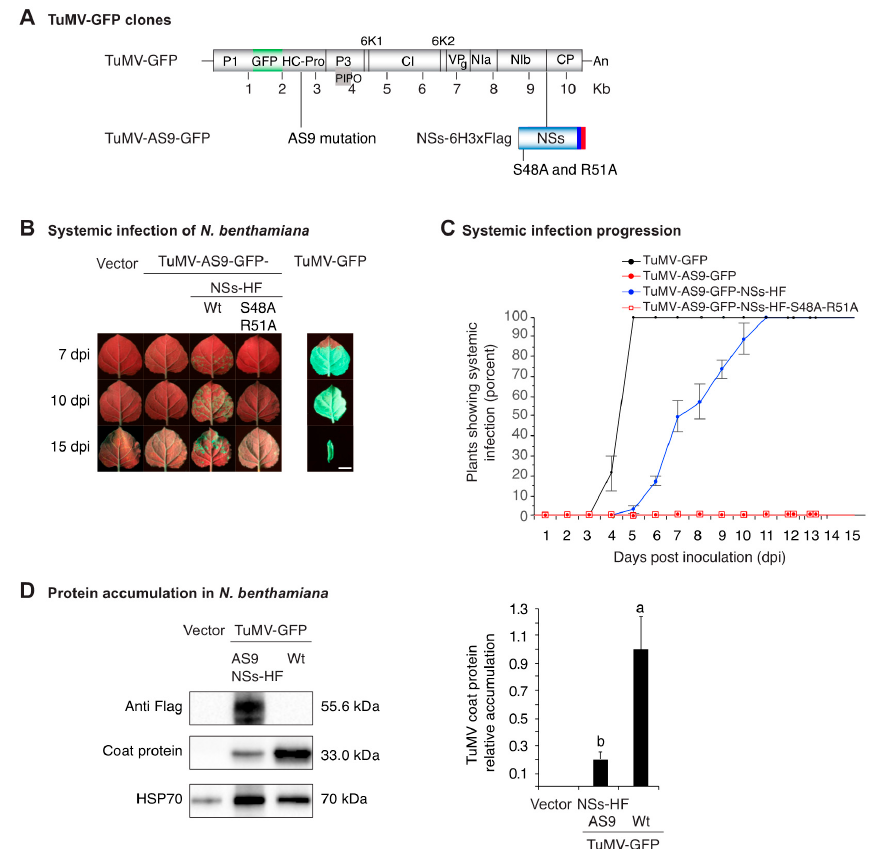
Figure 2. Pathogenicity in N. benthamiana and accumulation of suppressor-deficient TuMV-AS9-GFP derivatives expressing NSs-HF. ( A ) Representation of TuMV-GFP clones showing insertion of GFP between P1 and HC-Pro, the AS9 mutation on HC-Pro, and insertion of NSs-HF between NIb and the coat protein. An NIa cleavage site (CVYHQ/A) was added between NIb and NSs-HF and between NSs-HF and the coat protein to promote release of NSs-HF after polyprotein processing. Inactivating mutations on NSs RNA binding motif one are indicated. ( B ) Visualization under UV light of systemic infection in leaves at 7, 10 and 15 dpi. TuMV-GFP is shown for comparison. Scale bar: 2 cm. ( C ) Proportion (%) of plants showing systemic infection as determined by UV illumination. Points represent average ( ± standard error) of three repetitions, each consisting of 12 plants per treatment. ( D ) Virus accumulation in systemically infected leaves at 10 dpi. Representative western blots showing NSs-HF and coat protein accumulation in the same sample. HSP70 was used as a loading control. The blot was cut in three parts before antibody probing. The histogram shows average coat protein accumulation ± standard error (four biological replicates) relative to TuMV-GFP. Bars with the same letter are not significantly different (Tukey’s test with α =